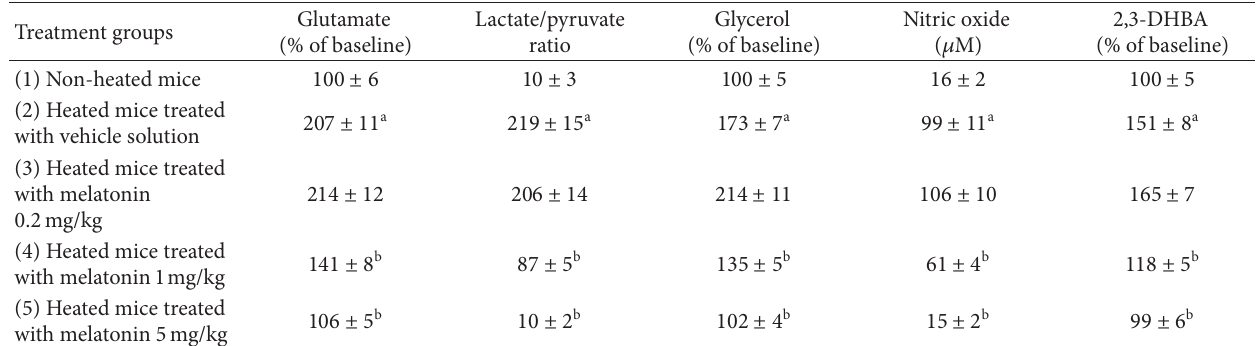
Table 2: Effect of heat exposure on hypothalamic levels of various parameters in different groups of mice. Treatment groups